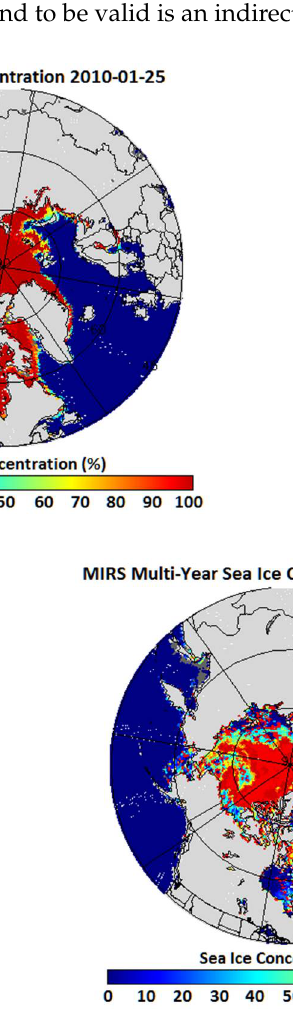
Figure 10. Polar-stereographic image of MiRS NOAA-18 derived Sea-Ice Concentration ( top-left ), First-Year Ice ( top-right ) and Multi-Year Ice ( bottom ) over the Arctic on 25 January 2010, based on MiRS dynamic emissivities. These products were validated extensively in [11].